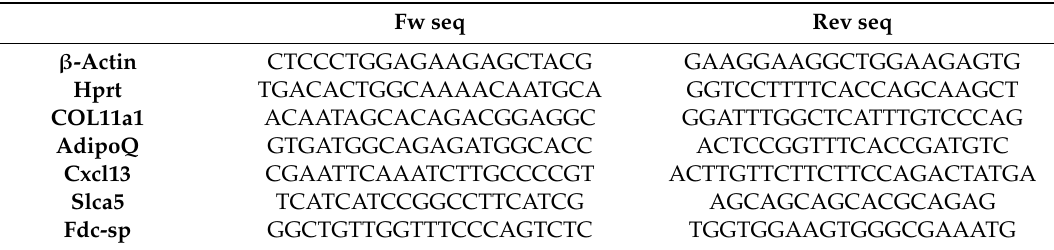
Table 1. Primer sequences used for qPCR